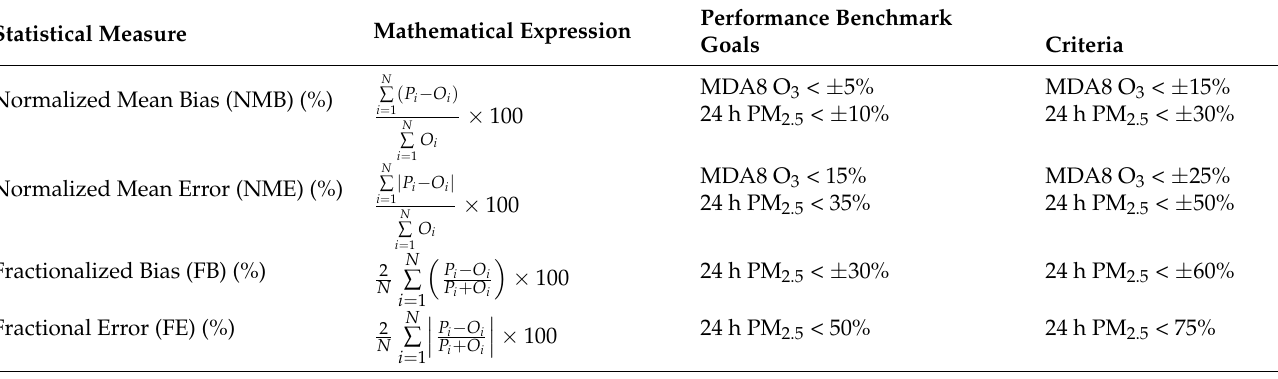
Table 3. Definitions of statistical model performance evaluation measures and performance